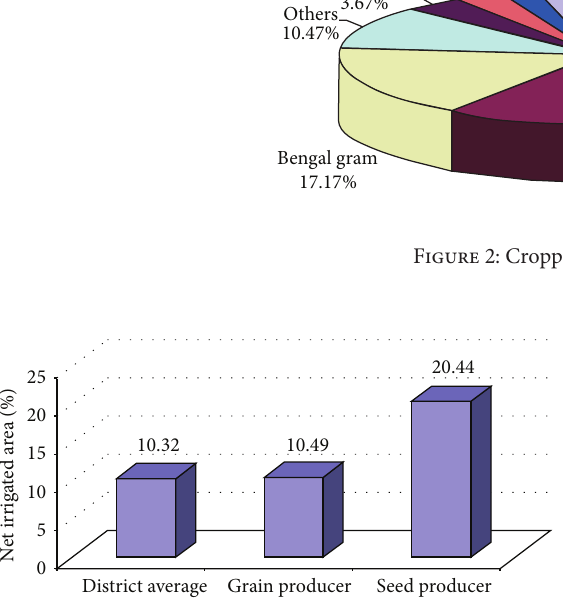
Figure 3: Irrigation pattern in study area.